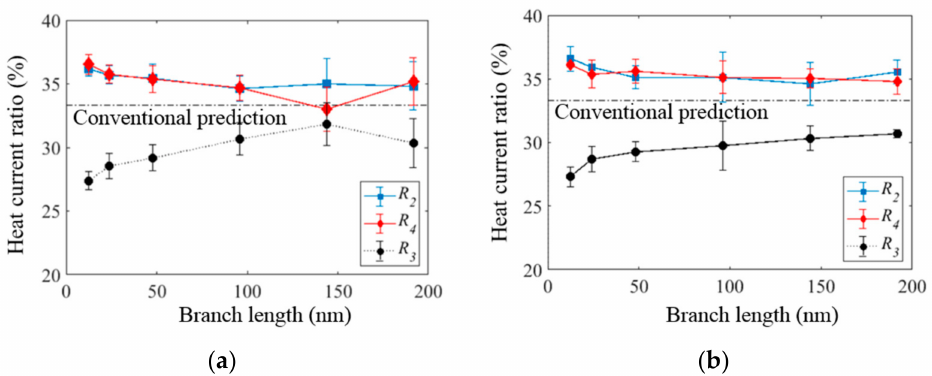
Figure 5. Branch length dependence of the heat current ratio for branched CNTs with two atomic configurations at the cross-junctions: ( a ) cross-junction 1 and ( b ) cross-junction